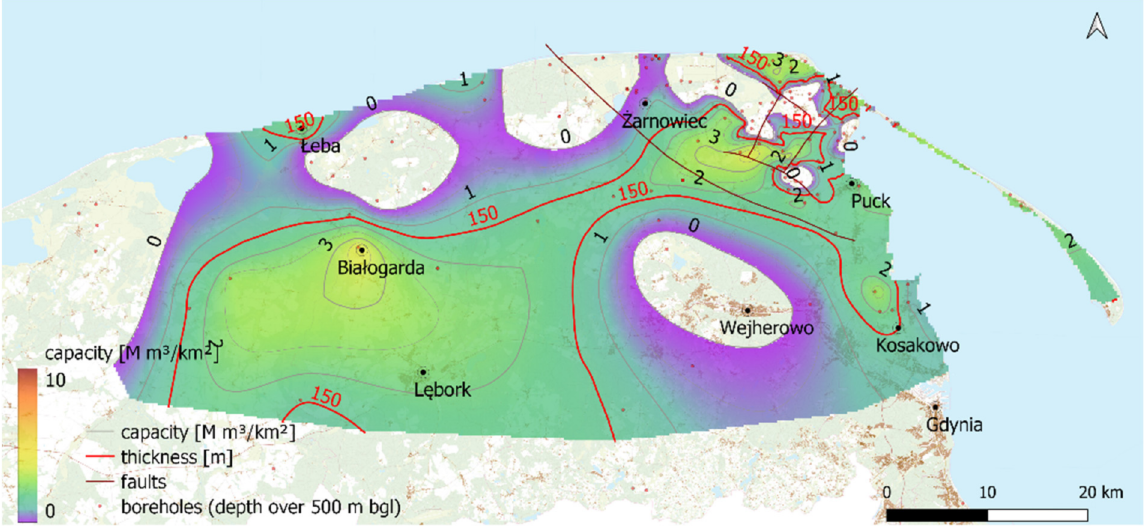
Figure 4. The storage capacity of liquid fuels in the rock salt layer in northern Poland, operational caverns (after the first filling).